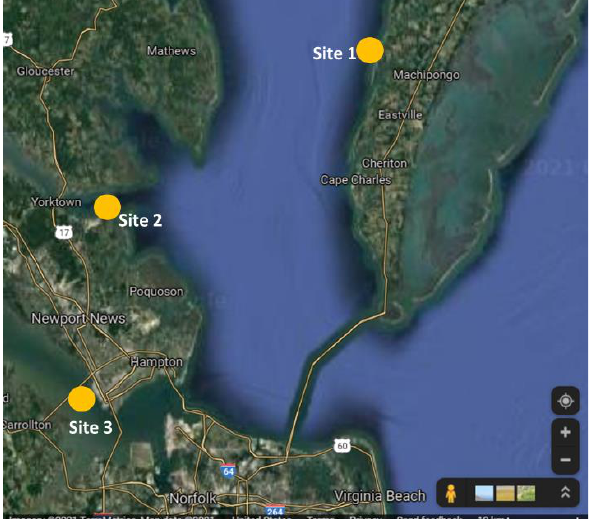
Figure 1. Sampling sites in the Chesapeake Bay in Virginia. Site 1: Eastern Shore; Site 2: York River; Site 3: James River.